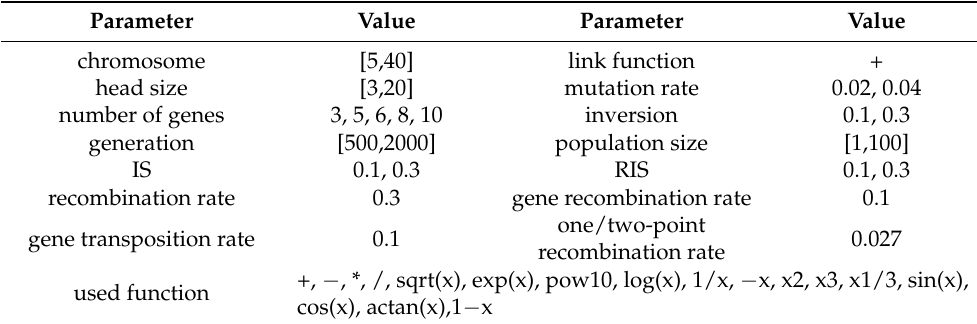
Table 1. The range of applied parameters in adjusting GEP